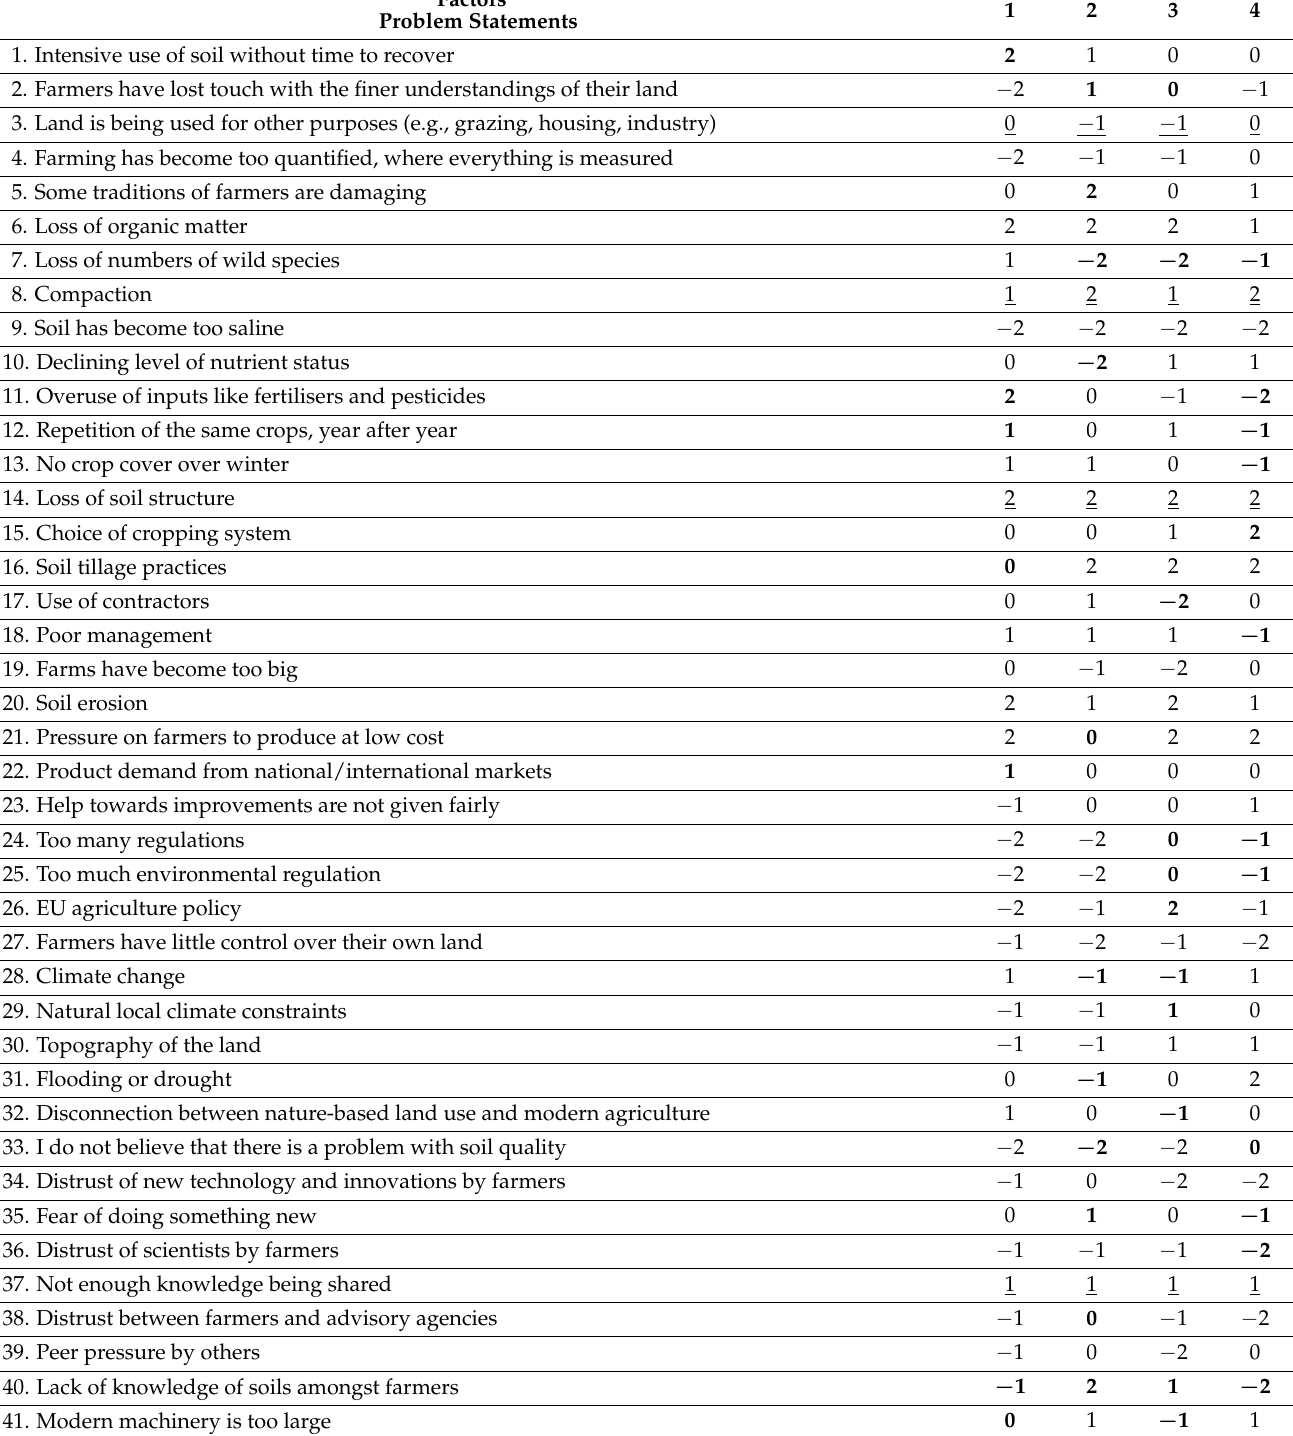
Table A1. Average Q-sort scores for each of the four factors identified as causing problems by UK respondents. Bold text indicates distinguishing statement at p < 0.01, underlined text indicates consensus statements; scale from − 2 (strongly disagree) to 2 (strongly